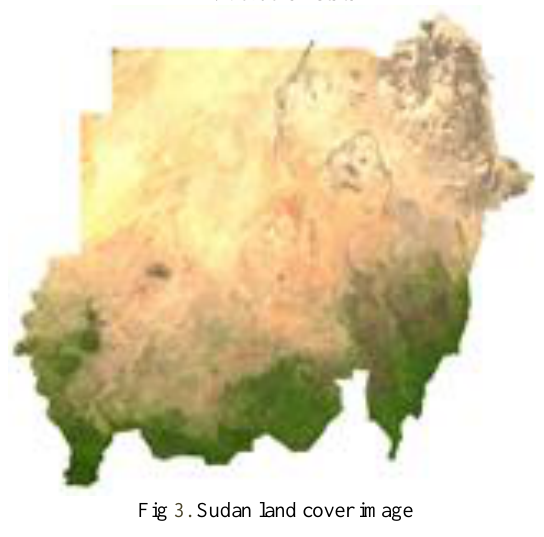
Fig 3. Sudan land cover